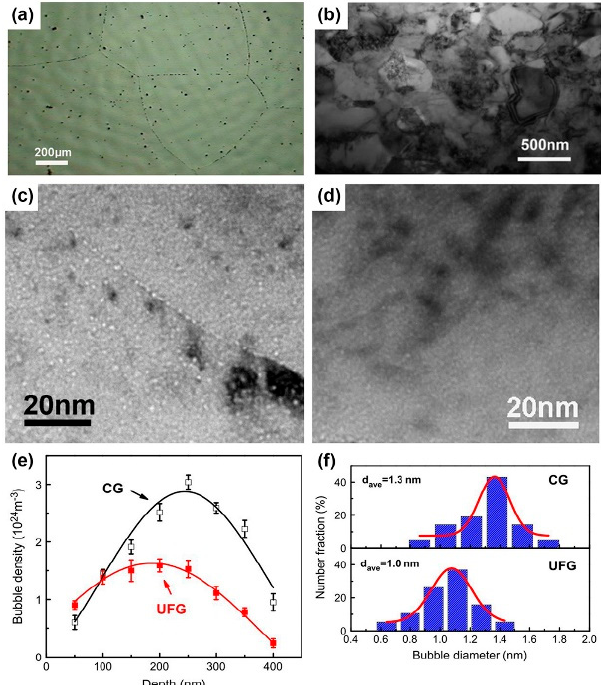
Figure 9. ( a ) An optical microscopy image of as-received coarse-grained (CG) Fe–Cr–Ni alloy. ( b ) TEM micrograph of ultrafine grain (UFG) Fe–Cr–Ni alloy after equal channel angular pressing (ECAP). ( c , d ) Under focused TEM micrograph of He ion irradiated CG and UFG Fe–Cr–Ni alloys. ( e ) Depth dependent bubble density in irradiated CG and UFG Fe–Cr–Ni alloy. ( f ) Bubble diameter distribution